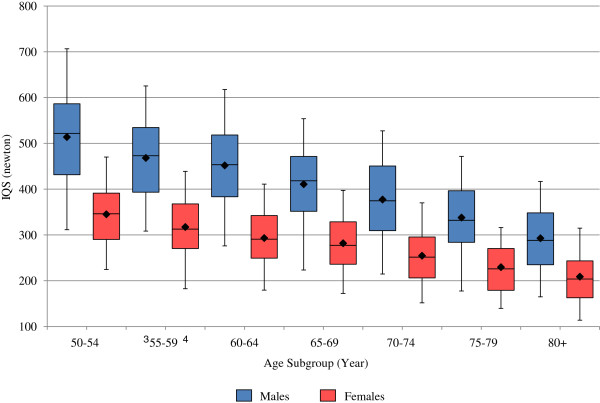
Distribution of muscle strength by age and gender. Lower half of boxplot depicts 25th percentile, upper half of boxplot represents 75th percentile, horizontal line dividing upper and lower half of boxplot represents median, upper whisker represents 95th percentile, lower whisker represents 5th percentile; and solid diamond in boxplot represents mean. IQS = Isokinetic quadriceps strength.